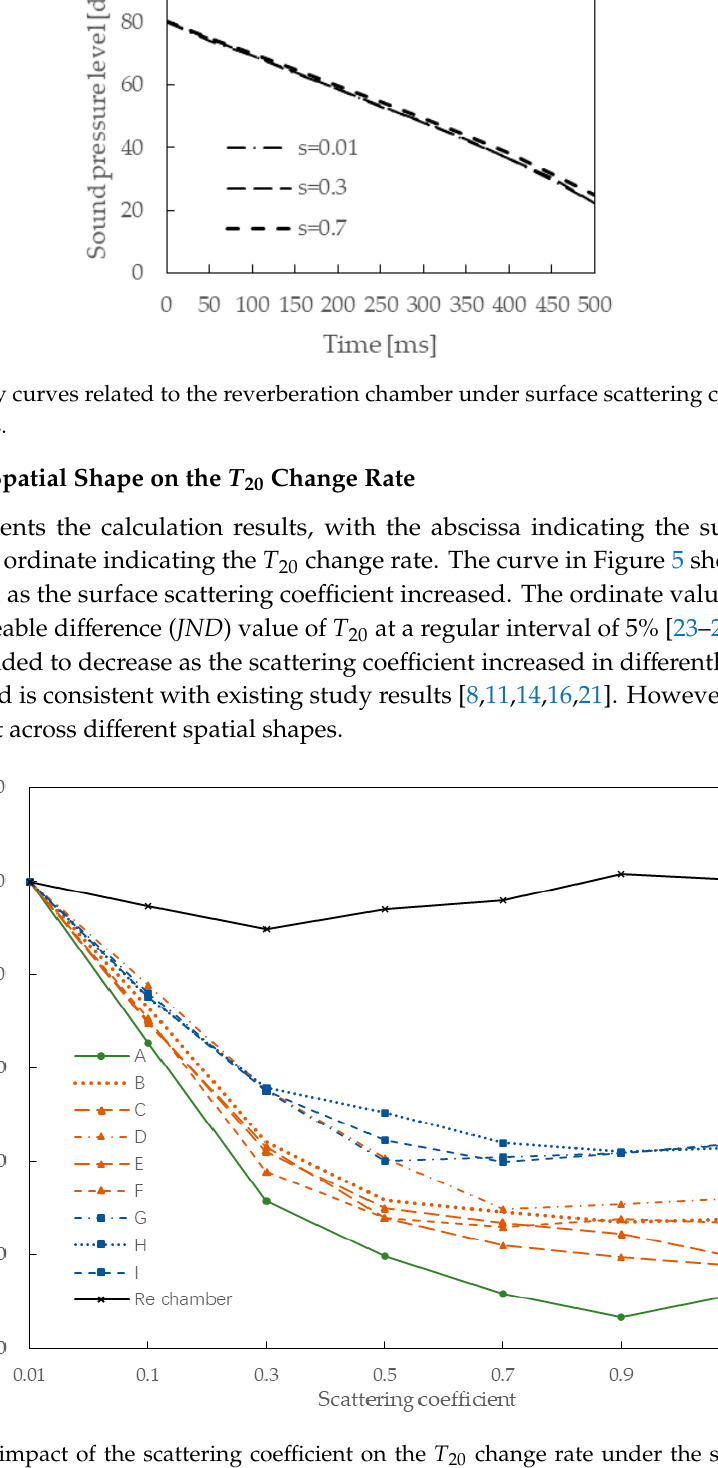
Figure 3. Decay curves related to the rectangular space under surface scattering coefficients of different values